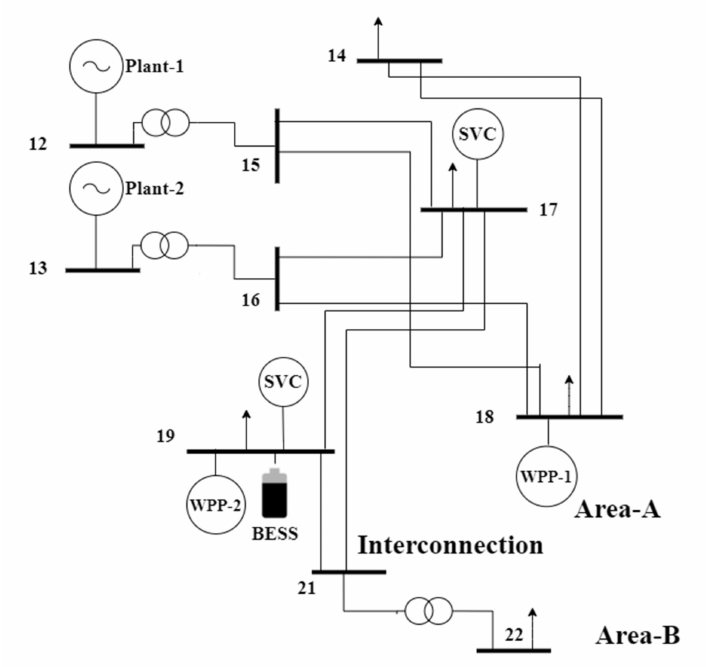
Figure 7. Single-line diagram of the test network.